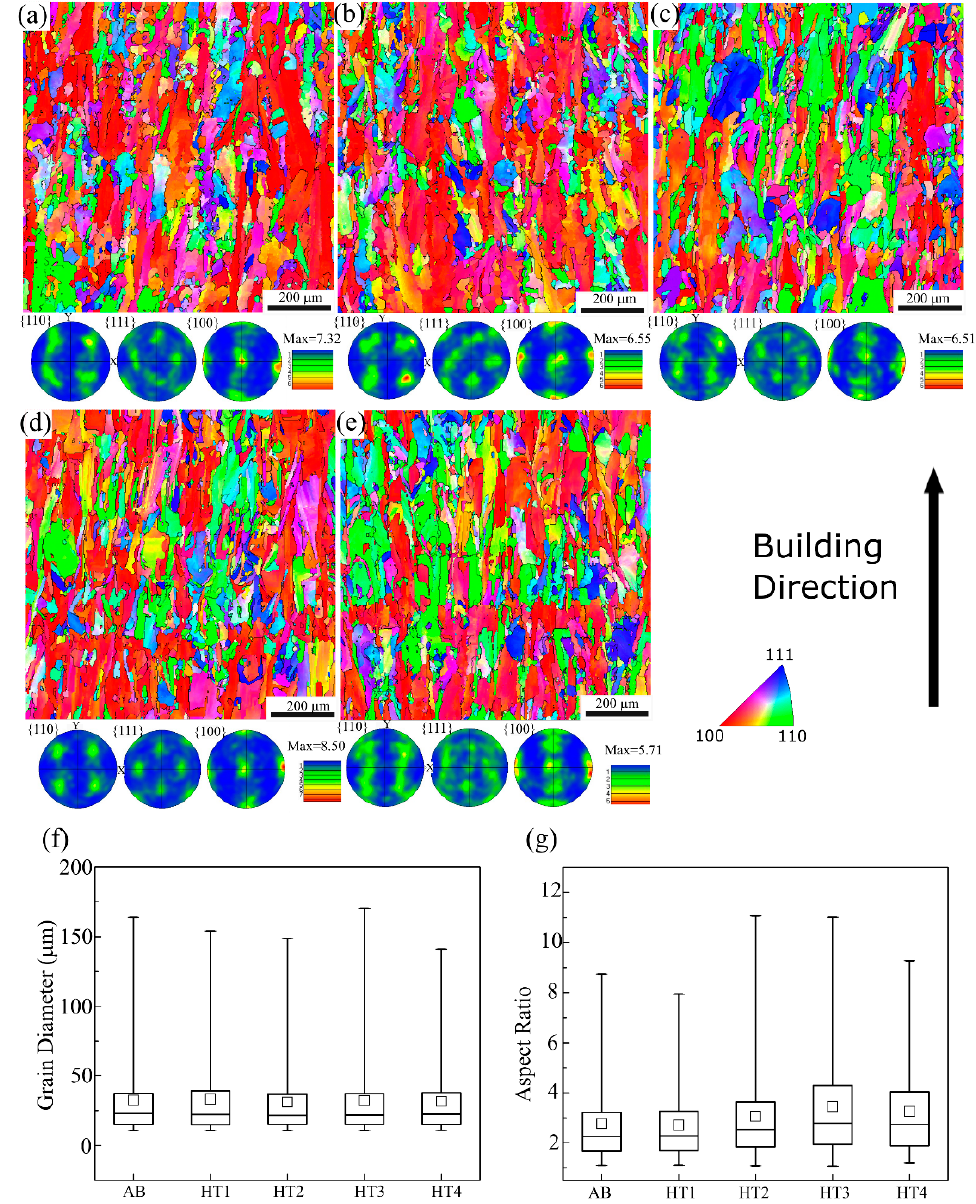
Figure 6. IPF orientation maps and corresponding pole figures of the ( a ) AB, ( b ) HT1, ( c ) HT2, ( d ) HT3, and ( e ) HT4 specimens. Box plots show the distributions of ( f ) grain diameter, and ( g ) aspect ratio for each specimen condition.